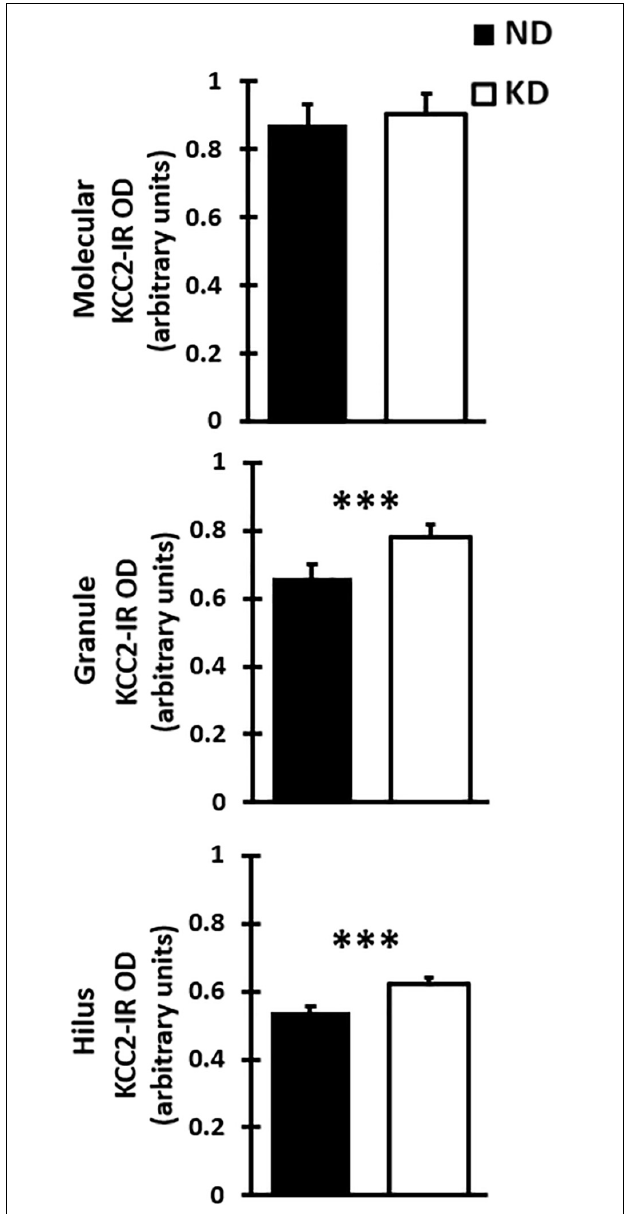
FIGURE 5 | Bar graph shows mean and SD of optical density (OD) of KCC2 expression in the three layer of the dentate gyrus of rats fed with normal diet (ND) or ketogenic diet (KD), n = 8 in each group. The KD does not significantly change the OD when compared with ND rats in the molecular layer. However, there was a significant increase in optical density of KD group when compared with DN group in the granule layer and hilus of dentate gyrus ( ∗∗∗ p < 0.000, Student’s t